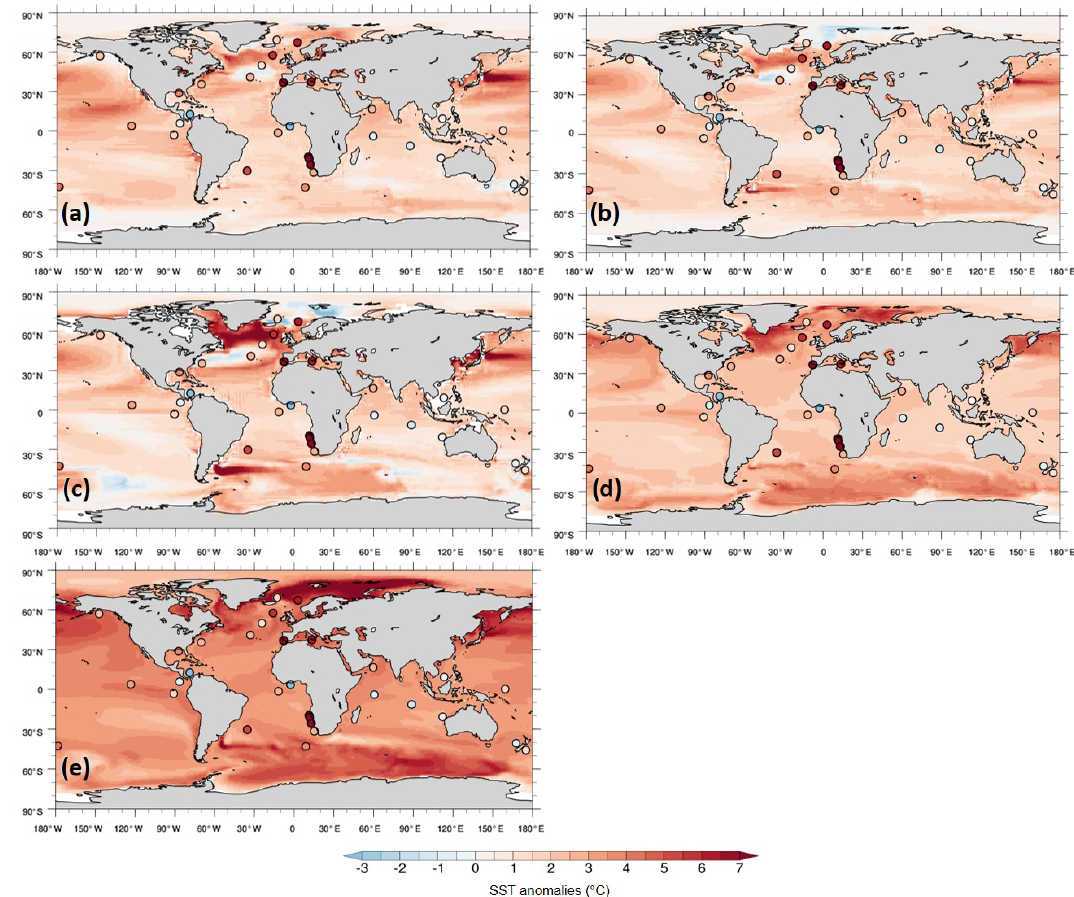
Figure 11. Annual mean SST differences (Pliocene − PI) from different generations of the UK’s physical climate model: (a) HadCM3- PRISM2, (b) HadCM3-PlioMIP1, (c) HadCM3-PlioMIP2, (d) HadGEM2 and (e) HadGEM3. Background gridded data show model simu- lations, and filled circles show SST proxy data from McClymont et al.